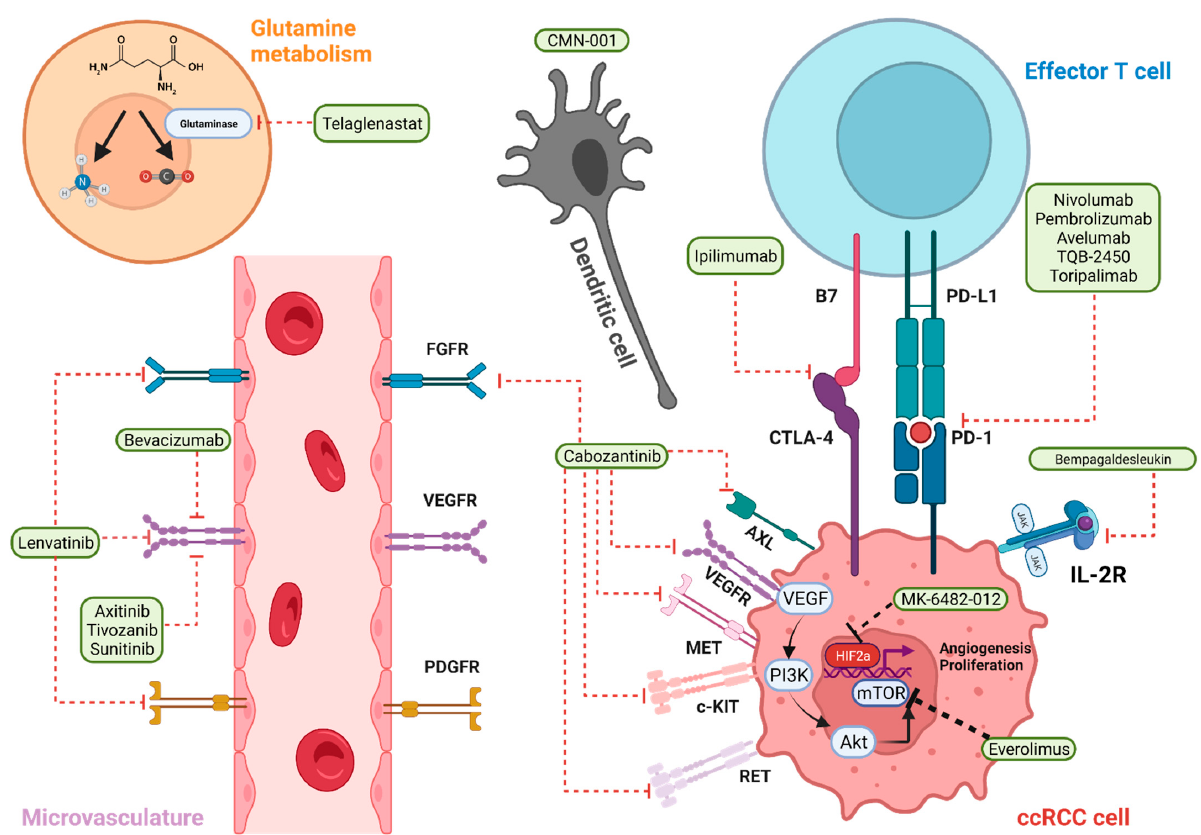
Figure 1. Current and novel therapies for mccRCC and their respective molecular targets. Created using Biorender ® . using Biorender ®